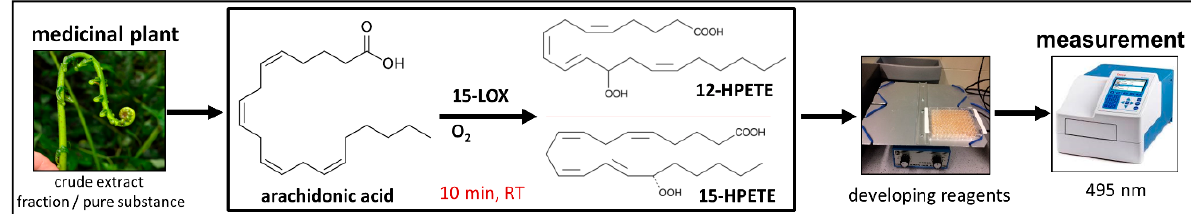
Figure 7. LOX-15 inhibition assay flow sheet depicting the experimental procedure.